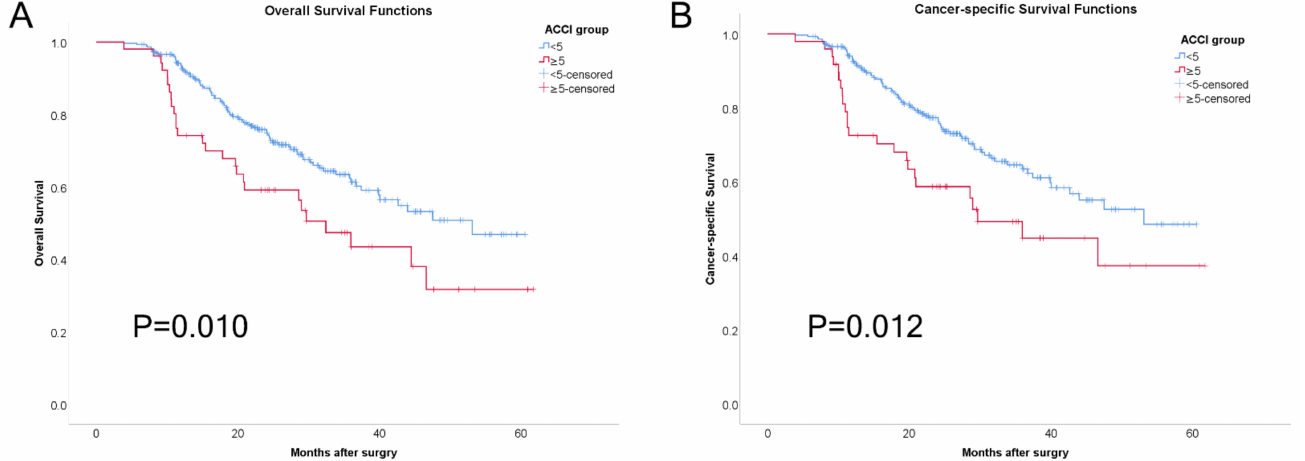
Figure 1. Kaplan–Meier curves for overall survival ( A ) and cancer-specific survival ( B ) for the different ACCI groups.